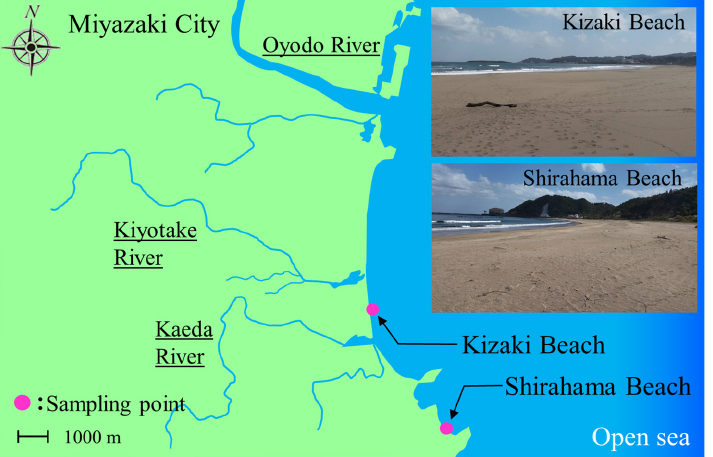
Figure 1. Coastal beaches, namely, Kizaki Beach (31°49 ′ 53.2 ″ N 131°27 ′ 08.8 ″ E) and Shirahama Beach (31°47 ′ 15.0 ″ N 131°28 ′ 53.5 ″ E), were sampled in this study.